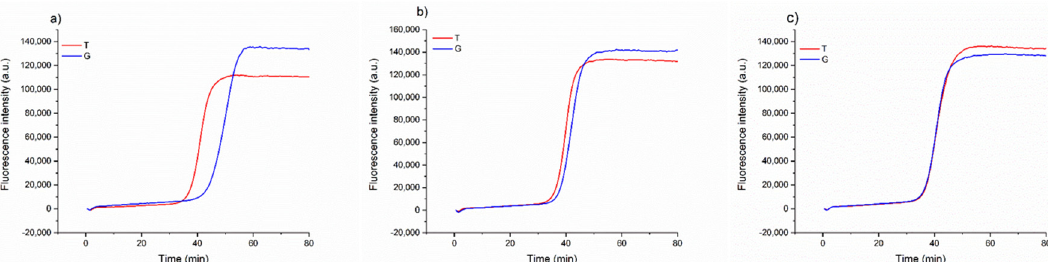
Figure 4. Real-time fluorescence detection of a simulated adulteration, in which a sample of Aureo was mixed with different proportions of a G-type variant (Babylone). ( a ) 90% of Aureo with 10% of G-type variant; ( b ) 75% of Aureo with 25% of G-type variant; ( c ) 50% of Aureo with 50% of G-type variant. The LAMP reactions were performed with loop primer T (red line) and G (blue line) at 63 °C.